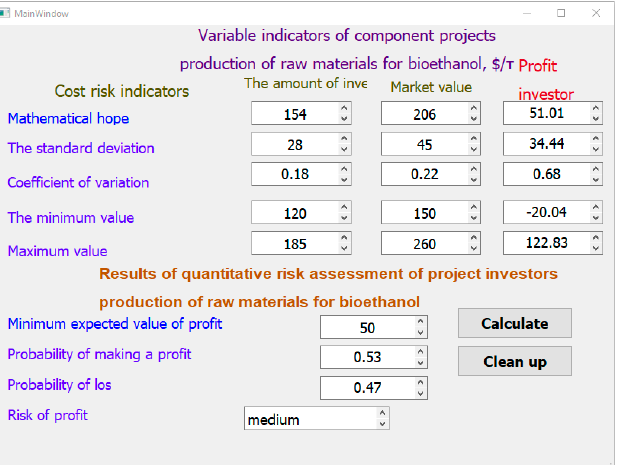
Figure 2. Theoretical curves of the amount of investments in the project of production of raw materials for bioethanol from wheat and its market value For qualitative and accelerated quantitative assessment of the risk of profits of investors in projects for the production of raw materials for bioethanol, based on the reasonable approach and the above theoretical principles developed application software in Python 3.8 (Figure 3).